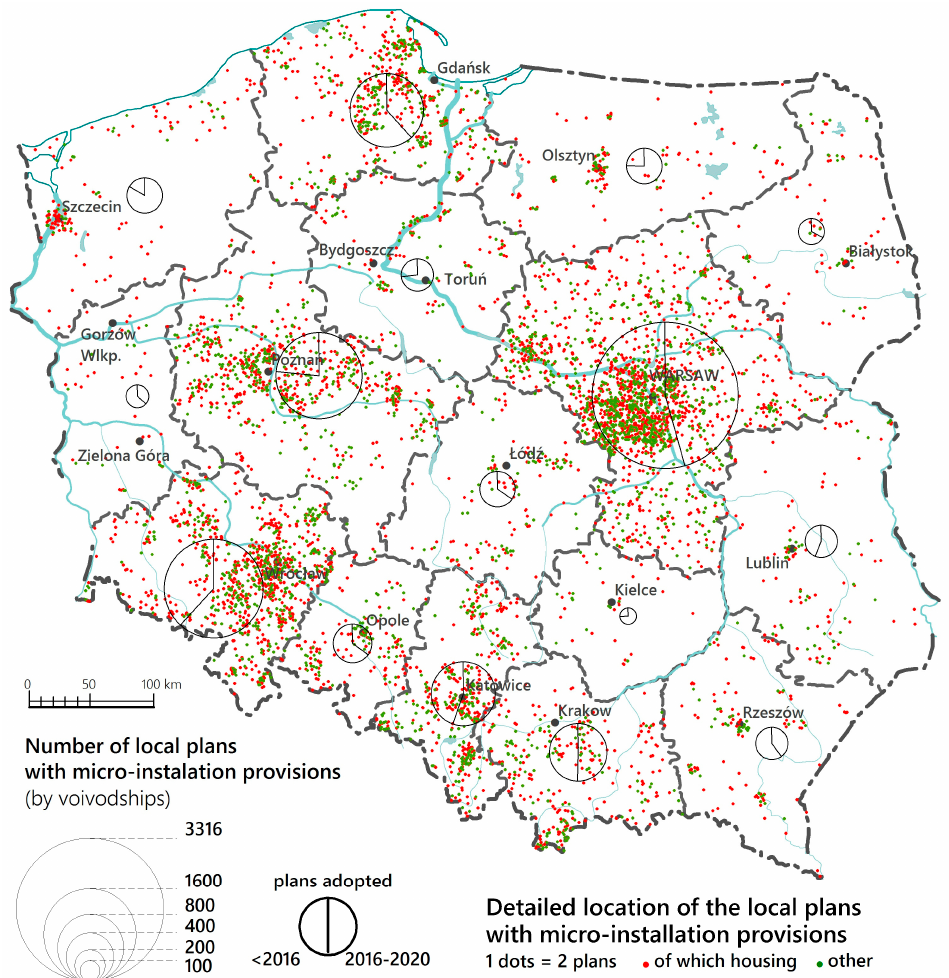
Figure 4. Location of local plans, in which arrangements related to micro-installations were made at the end of 2020.